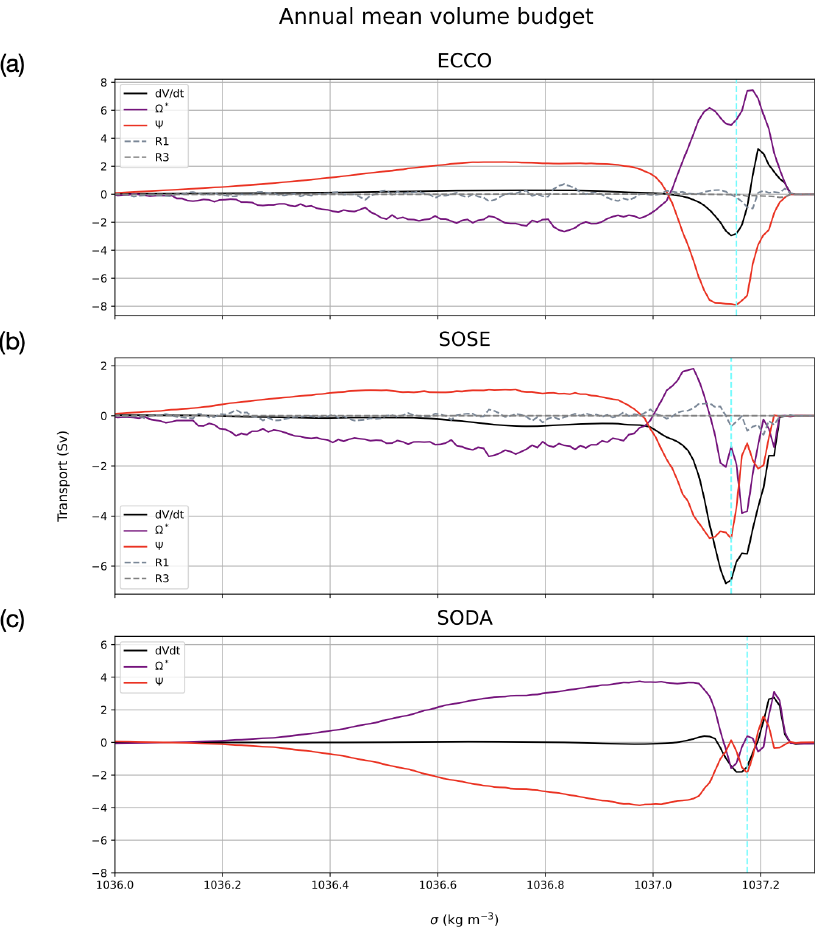
Figure 5. Main terms of the WMT volume budget in σ space (kgm − 3 ) averaged over each model’s respective time period for (a) ECCO (1992–2016), (b) SOSE (2006–2010) and (c) SODA (1993–2019). Volume change is represented by the black line and transport by the red line, transformation is the purple line (includes numerical mixing in ECCO and SOSE, and in SODA it also includes discretization residual), and the discretization residual is explicitly shown as the grey dashed line in ECCO and SOSE. The vertical dashed line demarcates the boundary of bottom water in each model (1037.155kgm − 3 for ECCO, 1037.145 for SOSE and 1037.175kgm − 3 for